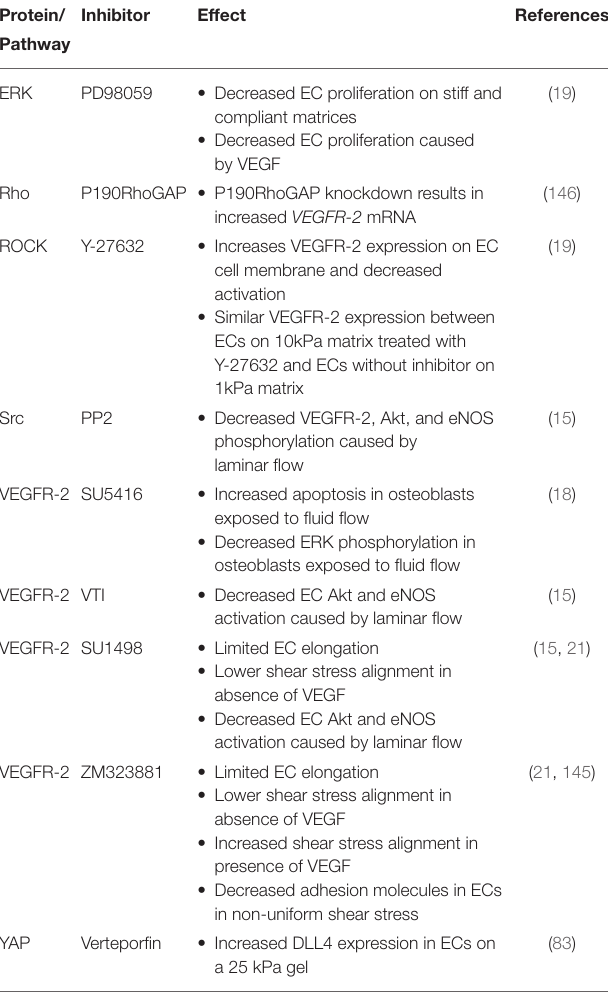
TABLE 1 | Effects of inhibitors on EC mechanobiological pathways. Protein/